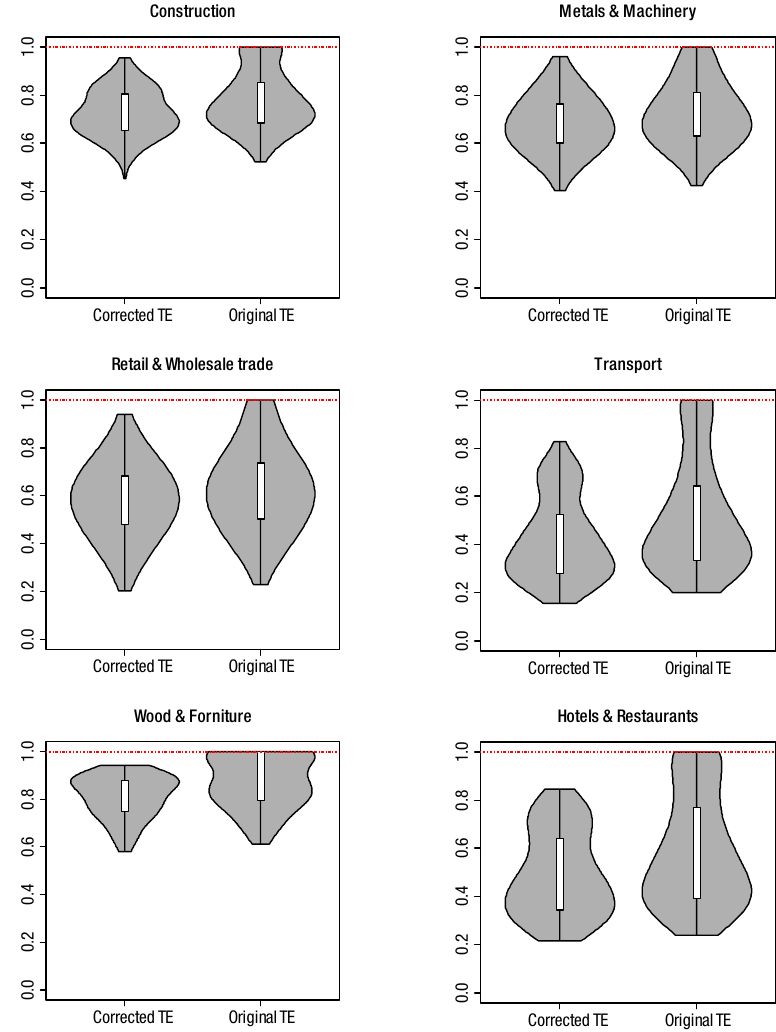
Fig. 2. Comparison original and corrected technical efficiency by